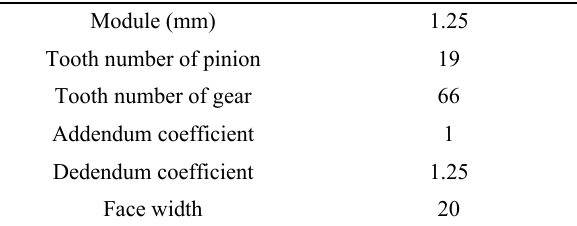
Table 1 Basic design parameters for gear pair.